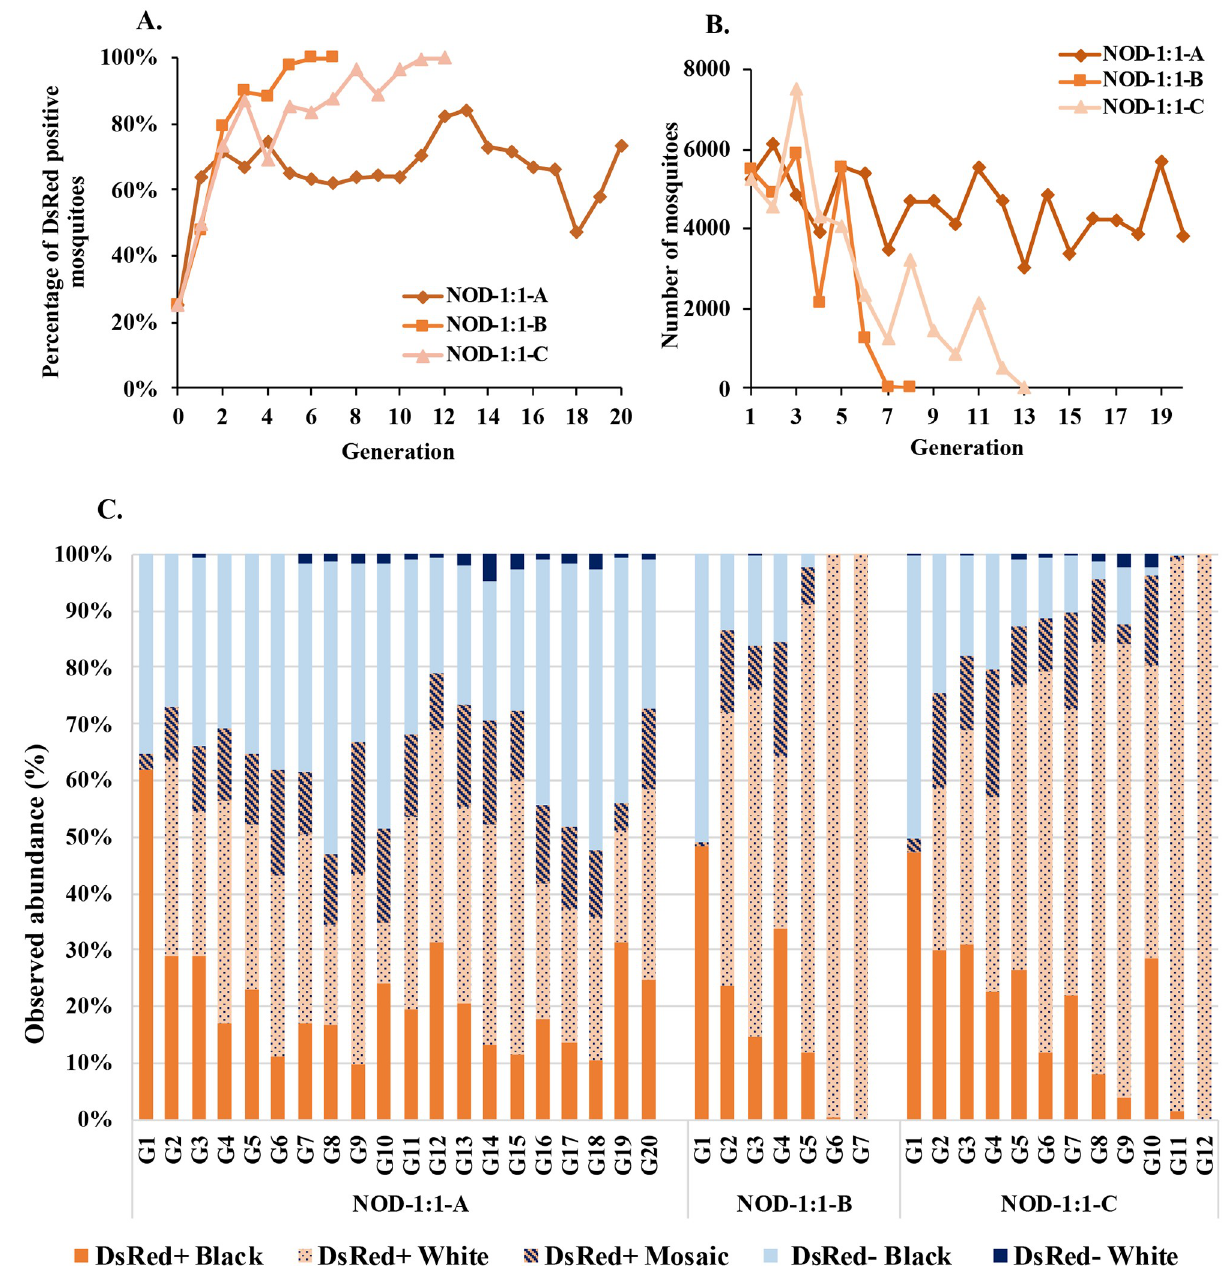
Fig 3. Non-overlapping gene drive (NOD) cage trial with initial releases of 1:1 transgenic AsMCRkh2 to wild-type males. Three cages (NOD-1:1A, NOD-1:1B and NOD-1:1) were seeded initially with 100 wild-type female, 50 wild-type male and 50 AsMCRkh2 male pupae. The resulting next generation larvae, pupae and adults were scored as DsRed-positive (DsRed + , carrying the AsMCRkh2 gene drive cassette) or wild-type. (A) Percentages of DsRed-positive (DsRed + ) adult mosquitoes (Y-axis) in the total population in each cage scored at each generation (X-axis). (B) Total population size (Y-axis) in each replica cage at each generation (X-axis). (C) Abundance in percentages (Y-axis) of eye color and DsRed phenotypes of ~500 randomly- selected pupae per generation in each cage.